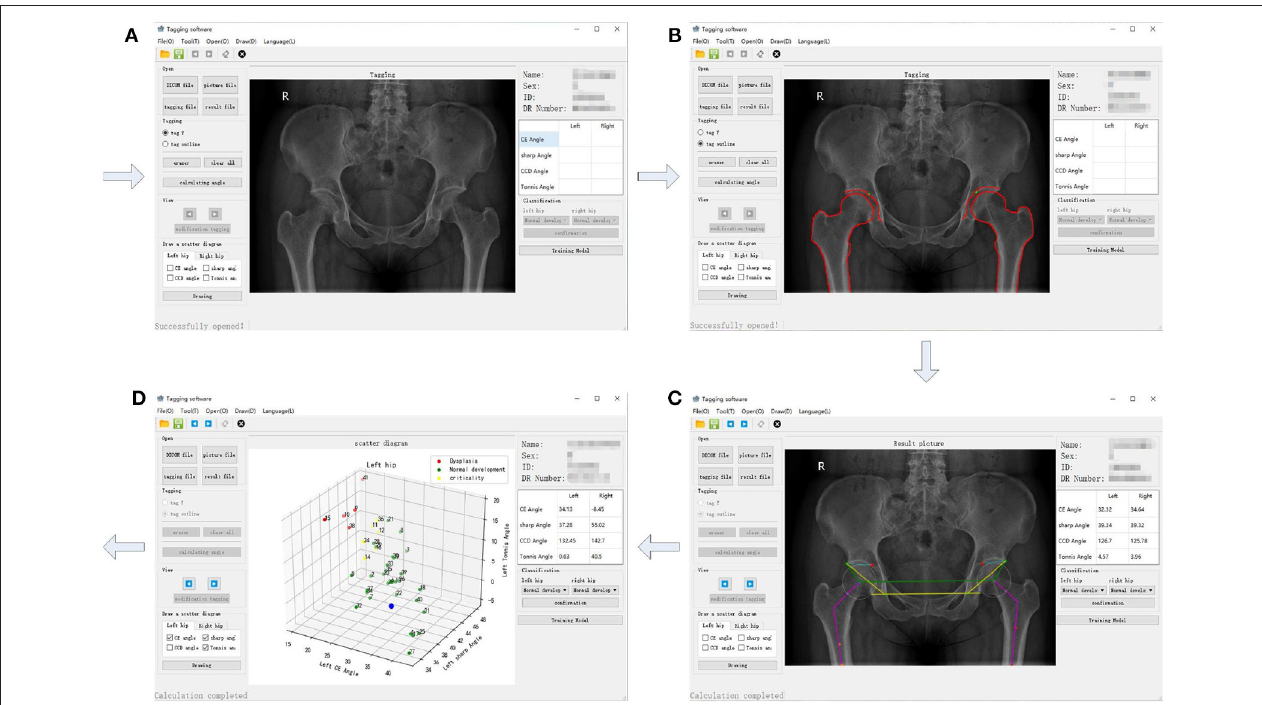
FIGURE 4 | The graphical user interface (GUI) of the semi-automatic method for diagnosis of hip dysplasia on X-ray films. (A–D) correspond to four steps of the